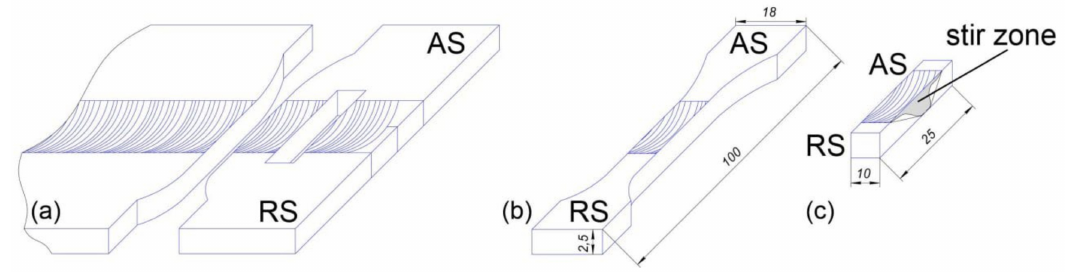
Figure 3. Scheme of the FSW seam sectioning ( a ) for cutting off tensile ( b ) and metallographic ( c ) specimens. AS and RS are the advancing and retreating sides of the seam, respectively.